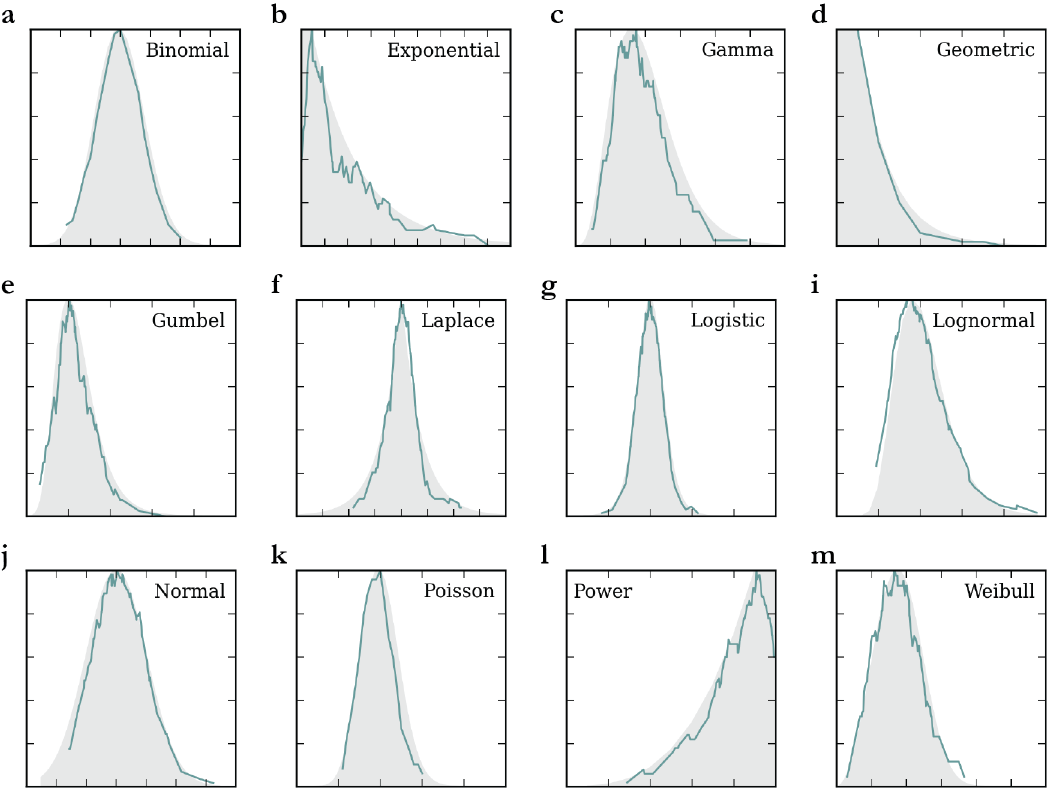
Fig 2. Application of NB Methodology on Twelve Simulated Distributions. For each type of distribution, 100 values were randomly simulated. The degree-value curves are shown in solid green lines, and the theoretical distributions are shown in shaded gray. The distributions and curves were standardized between 0 and 1 to fit on the same scale. The properties and results for each distribution are available in Section E in S1 File.